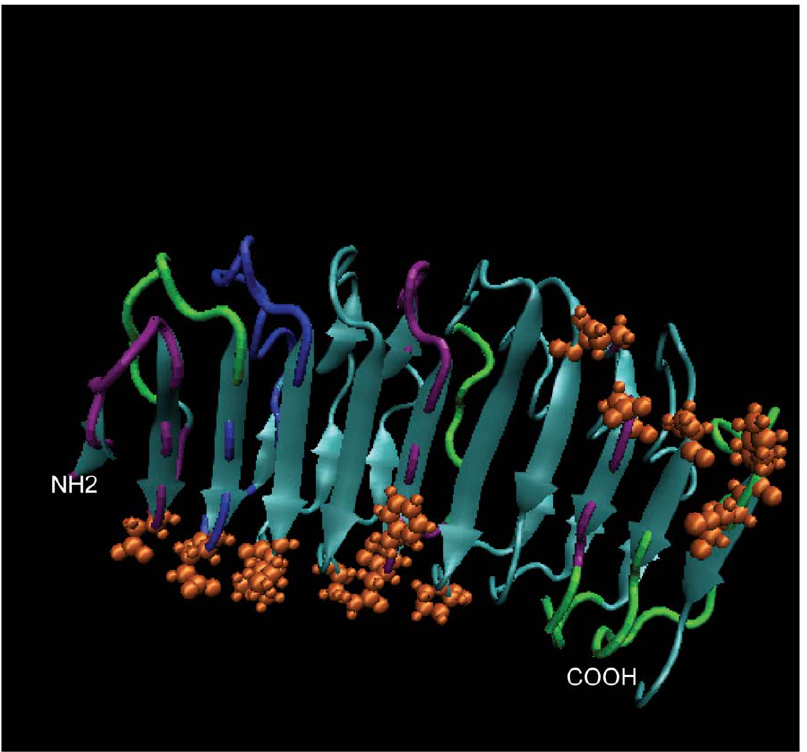
Figure 5. Mapping similar and unique antibody protected regions on TSHR LRD 3D structure. The 3D structure of the TSHR ectodomain, based on Sanders et al (20), illustrating the apparently protected regions following binding of MS-1 and M22 previously shown on the snake plot (Figure 4B). Purple represents common protected regions, Green the MS-1 unique regions, and blue the M22 unique regions. The major TSH binding residues are also shown in orange.